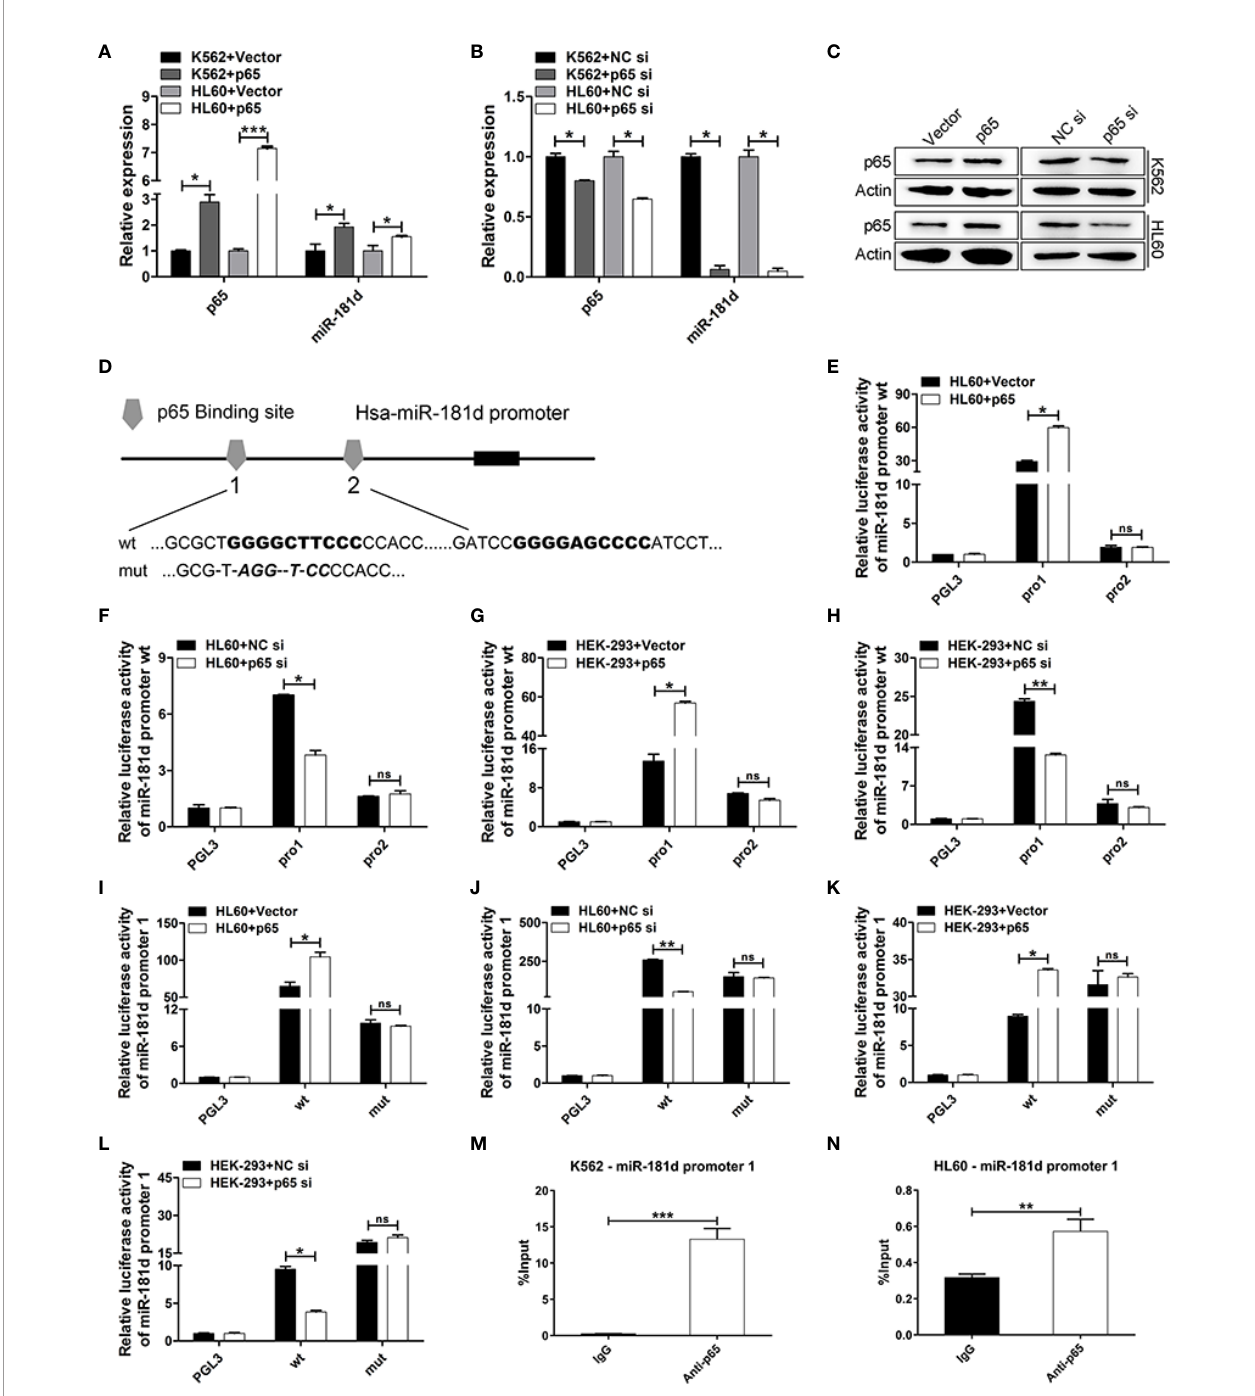
FIGURE 5 | miR-181d is directly upregulated by p65. (A, B) qRT-PCR of p65 mRNA and mature miR-181d levels after transfection with p65 plasmid or siRNA in K562 and HL60 cells. (C) Western blot analysis of p65 protein expression level after transfection with p65 plasmid or siRNA in K562 and HL60 cells. (D) Schematic illustration of the predicted p65 binding sites in the miR-181d promoter. (E – H) Regulation of miR-181d wild-type promoter by p65, including the fi rst p65 binding site (miR-181d pro1) and the second p65 binding site (miR-181d pro2). HL60 and HEK-293 cells were transfected with miR-181d wild-type reporters together with p65 plasmid/siRNA and the luciferase activity was assessed 48 h or 72h post-transfection. (I – L) miR-181d wild-type pro1 and its mutated form activities following with p65 plasmid or siRNA transfection in HL60 and HEK-293 cells. (M, N) ChIP assay for p65 binding to the miR-181d promoter in K562 and HL60 cells. The results are from 3 independent experiments. * P < 0.05, ** p < 0.01, *** p < 0.001, ns, not statistically signi fi